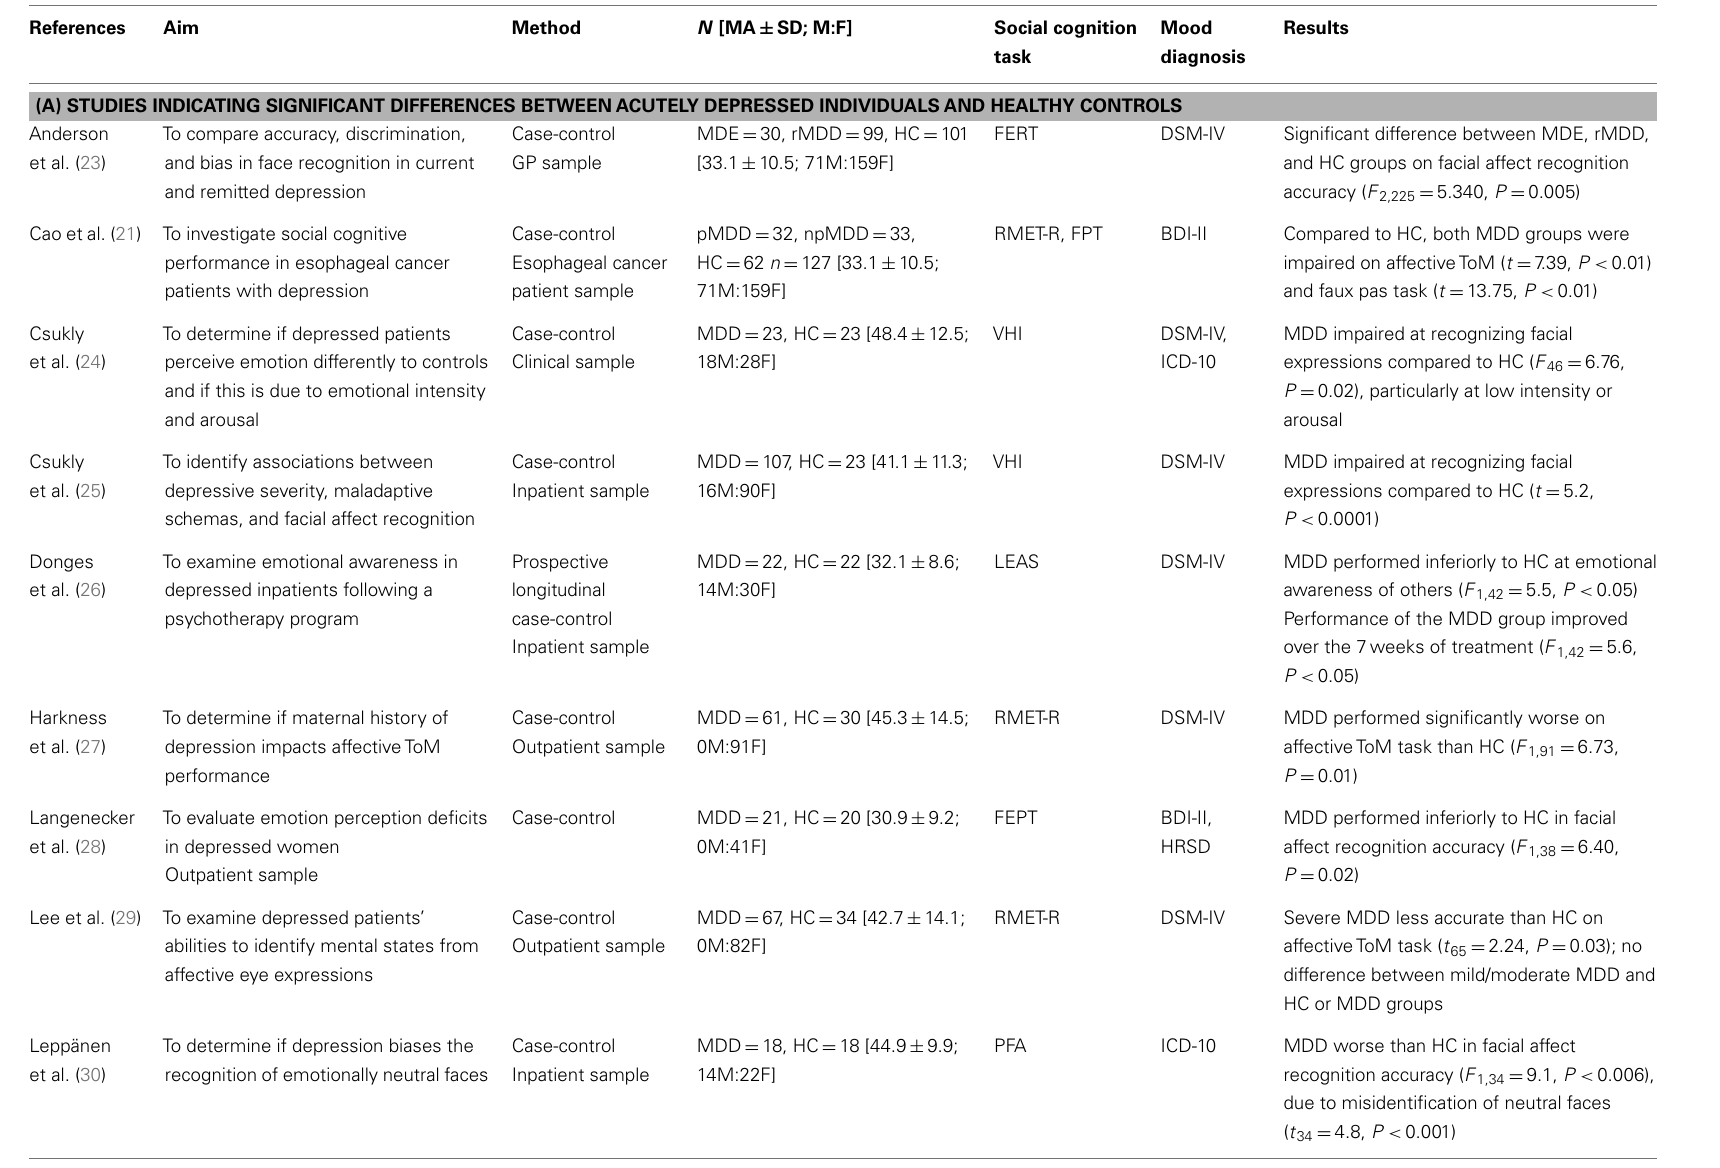
Table 1 | Case-control studies investigating differences in social cognitive performance between patients with major depressive disorder and controls